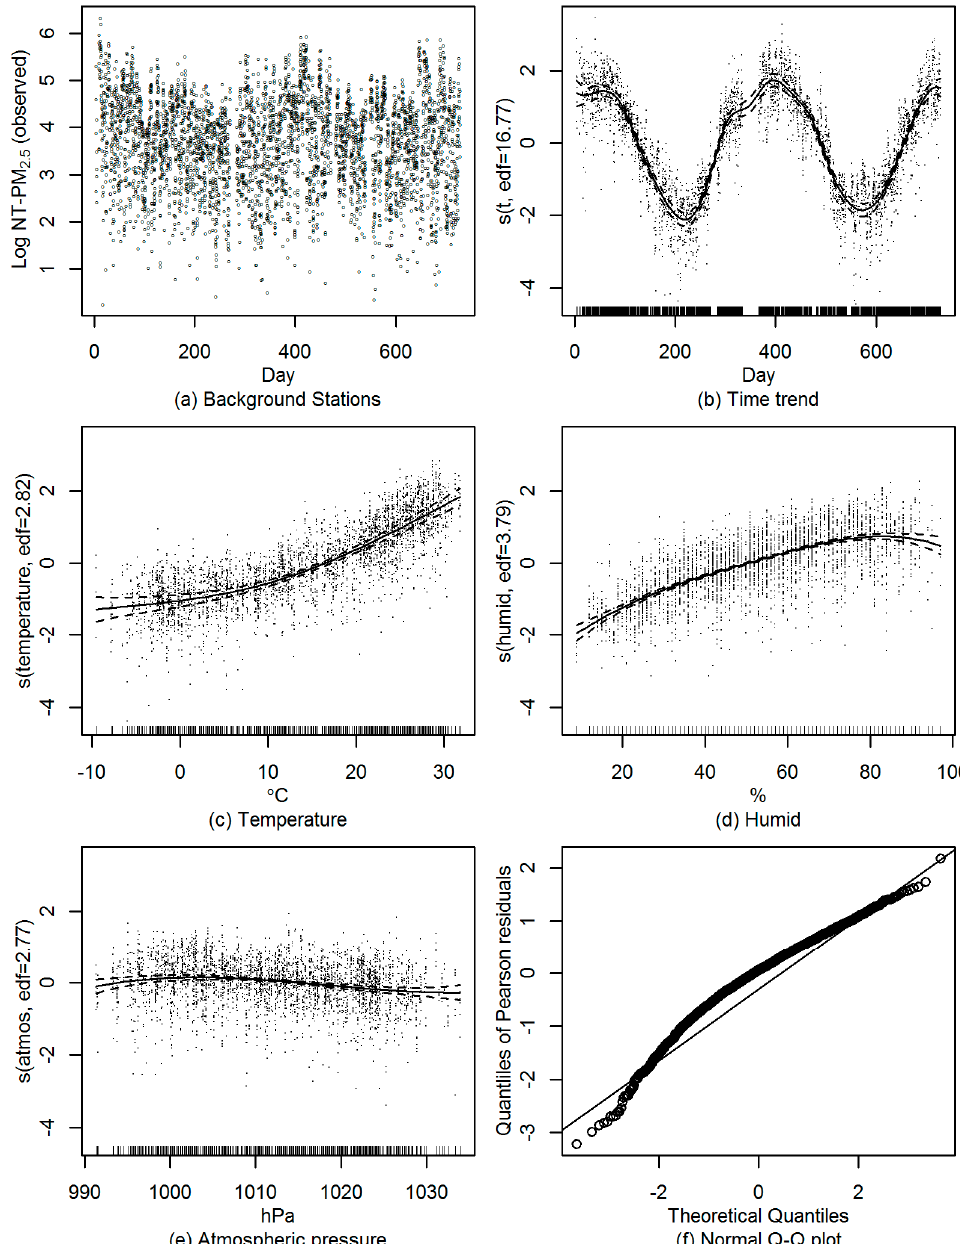
Figure 5. Diagnostic plots of GAMM on non-traffic PM 2.5 concentrations at background stations: ( a ) time trend of log transformed non-traffic PM 2.5 concentrations; ( b ) partial regression smooth curve of day with residuals; ( c ) partial regression smooth curve of temperature with residuals; ( d ) partial regression smooth curve of humid with residuals; ( e ) partial regression smooth curve of atmospheric pressure with residuals; ( f ) Q-Q plot of Pearson residuals.